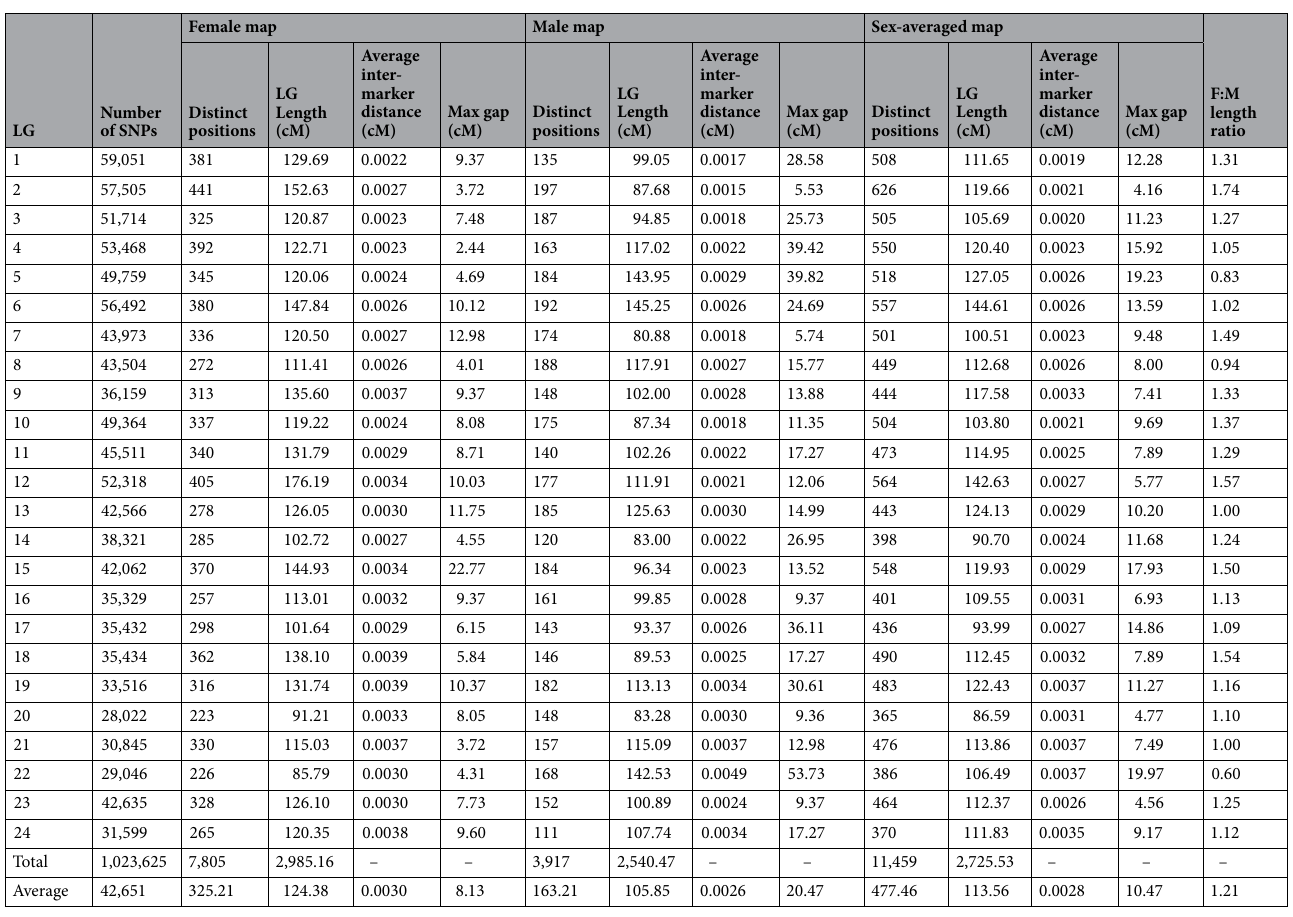
Table 2. Description of the female, male and sex-averaged linkage maps. LG: linkage group, cM: centiMorgan, F:M: